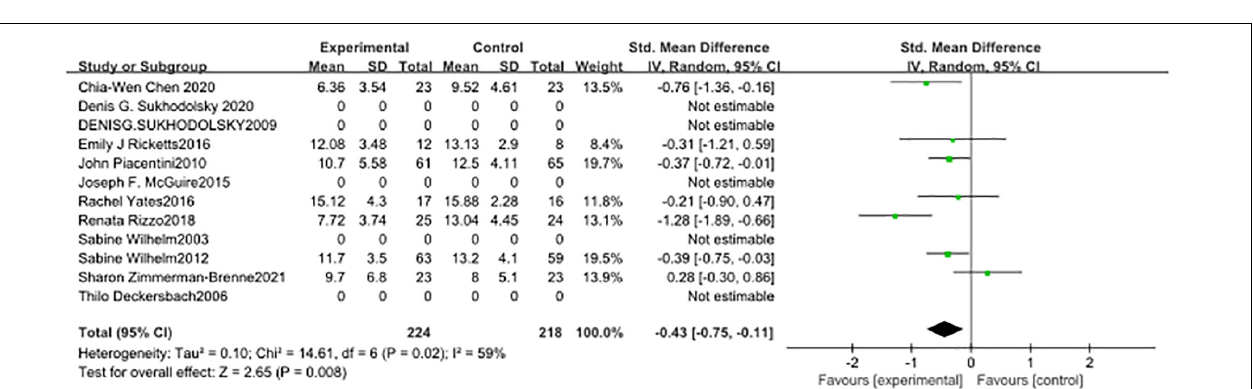
FIGURE 4 | Forest plot of the effect of cognitive-behavioral therapy (CBT) treatment groups vs. control groups on the total tic score.